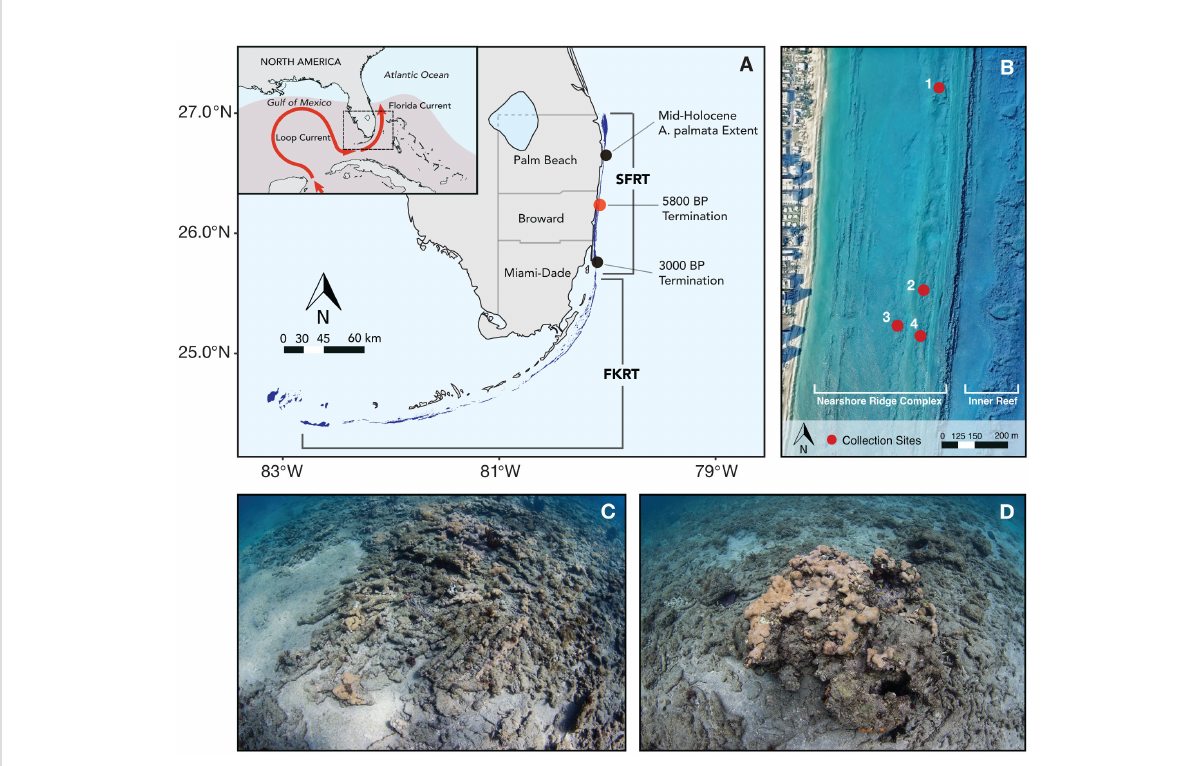
FIGURE 1 Description of the study area in relation to the broader biogeographical setting of the Florida reef tract. (A) Location of study area (red dot) on Southeast Florida reef tract (SFRT) extent, the full extent of which is shown by the dark blue polygon. Inset map shows main currents affecting the region. Estimated maximum Atlantic Warm Pool extent in fall (de fi ned as sea surface temperatures (SSTs) warmer than 28.5° [Wang et al., 2008]) is shaded in red. (B) Map of study area with sampling sites marked in red. Map was made by overlaying 1-m resolution lidar bathymetry and 1-m resolution aerial imagery. Bathymetric map was generated with digital elevation models acquired by U.S. Army Corp of Engineers in 2017. Aerial imagery was collected by PhotoScience, Inc. on March 8, 2013. (C) Interlocked sub-fossil Acropora palmata coral branches overlying antecedent coquinoid limestone surface. (D) Sub-fossil Orbicella spp. coral colony (~1.5 m diameter) surrounded by unconsolidated Acropora -dominated coral rubble and smaller branching coral rubble. Photos by